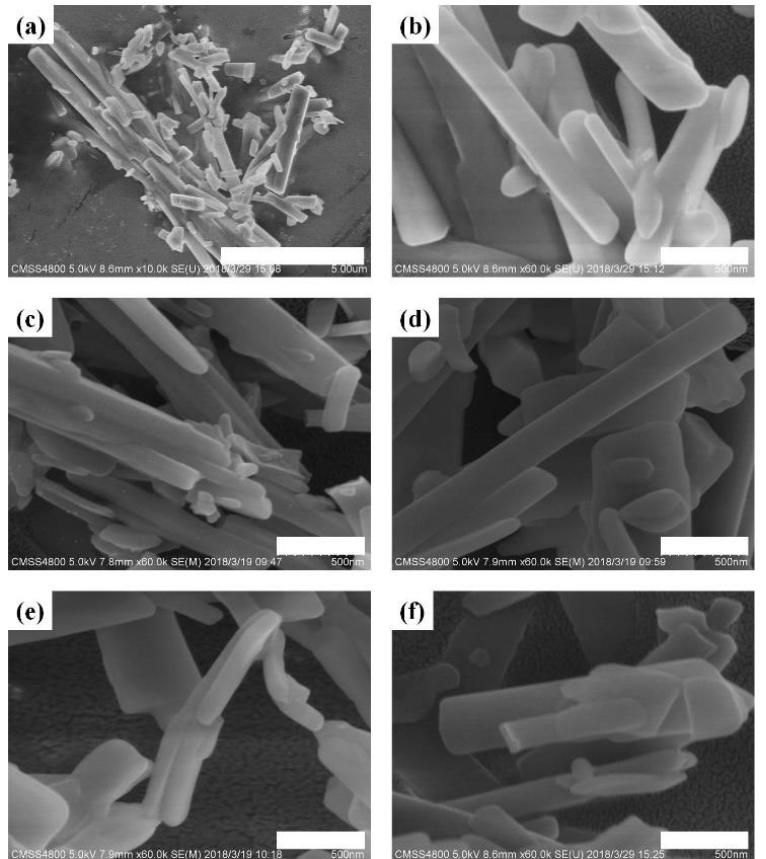
Figure 3. SEM images of the Ni-BTC samples obtained at various reaction times. ( a , b ) Ni-BTC-1 m, ( c ) Ni-BTC-5 m, ( d ) Ni-BTC-30m, ( e ) Ni-BTC-60 m, and ( f ) Ni-BTC-180 m. The bar in ( a ) represents 5 μm, and the bars in ( b – f ) to represent 500 nm.